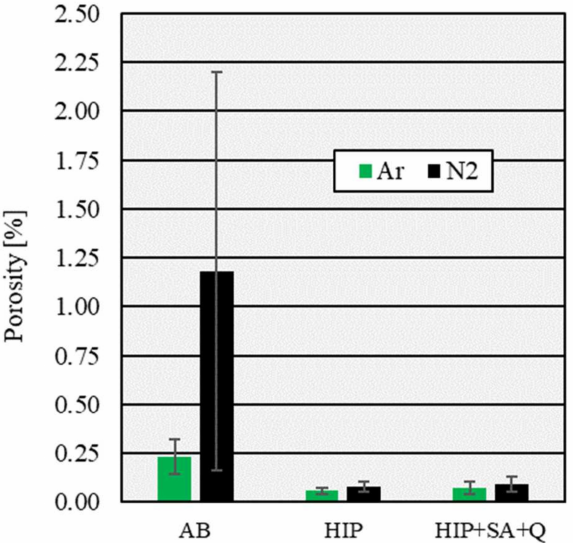
Figure 3. Porosity evolution of AISI 318LN along the L-PBF process